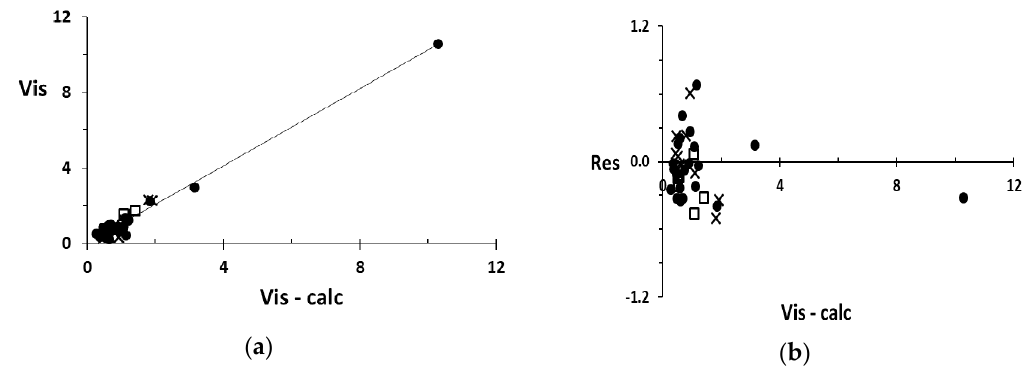
Figure 6. Plot of the Experimental vs. calculated (calc) viscosity, η , ( a ) and the corresponding residual plot ( b ): (•) training points, ( □ ) test points, and ( × ) evaluated points. Statistics of EV points: N = 9, r 2 = 0.98, s = 0.1.